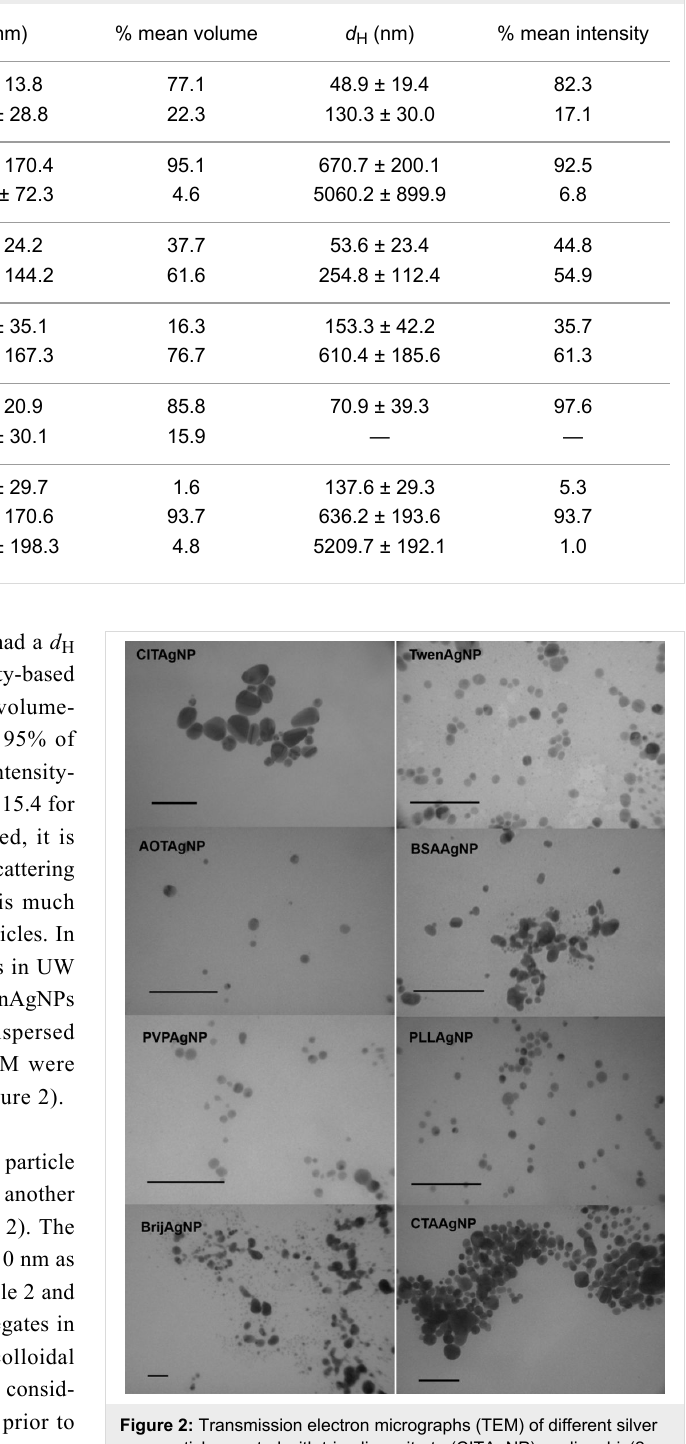
Table 2: Hydrodynamic diameter ( d H ) obtained from size distributions by volume and intensity of uncoated superparamagnetic iron oxide nanoparti- cles (UNSPIONs) and coated with poly(L-lysine) (PLLSPIONNs) or D-mannose (MANSPION) in ultrapure water (UW) and biological medium (BM) after 1 h at 25 °C.